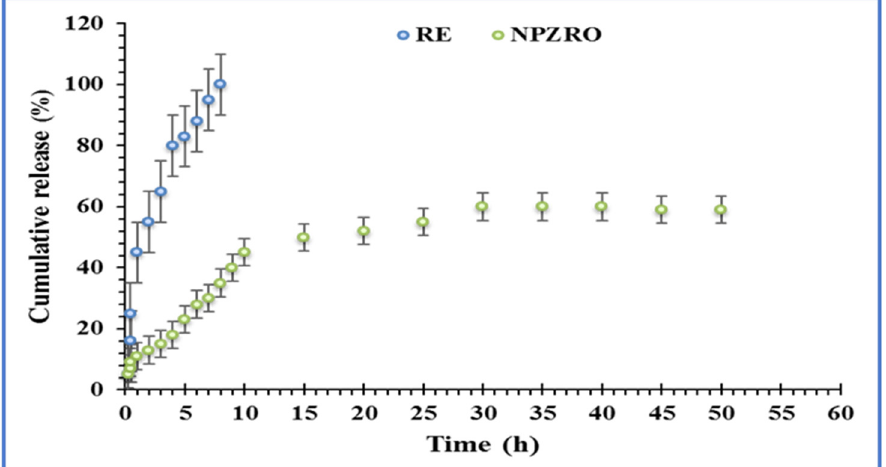
Figure 5. The RE-free and NPZRO’s release profiles.